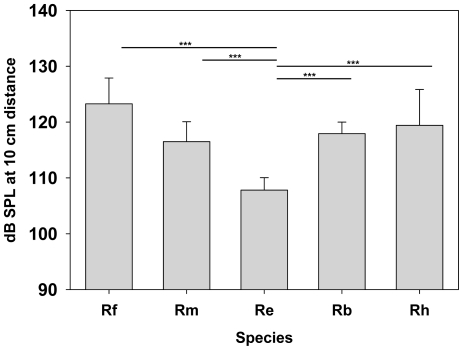
Interspecific call intensity relations.Maximum call intensities (in dB SPL; calculated for 10cm distance to the bats' nose) for R. ferrumequinum (Rf, N = 12), R. blasii (Rb, N = 6), R. mehelyi (Rm, N = 11), R. euryale (Re, N = 12) and R. hipposideros (Rh, N = 10). Lines and asterisks indicate the significant outcomes from all possible post-hoc pair wise comparisons (t-tests, p-values Bonferroni corrected, ***<0.0001).